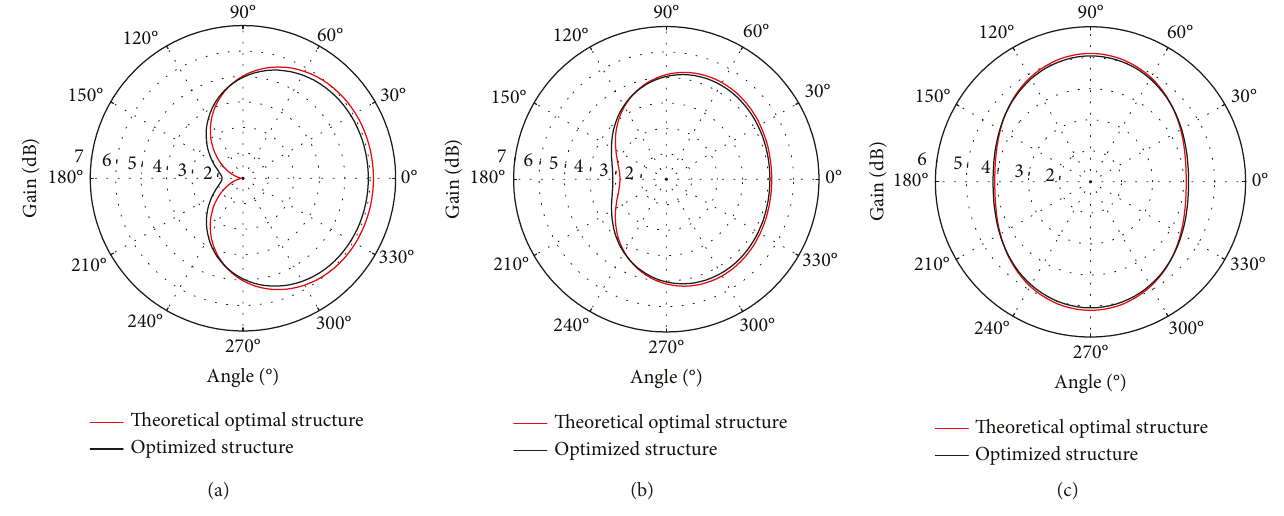
Figure 12: Horizontal patterns of the VLF umbrella arrays by CABMO: (a) 0 ° (180 ° ) beam position; (b) 60 ° (120 ° ) beam position; (c) 90 ° (270 ° ) beam